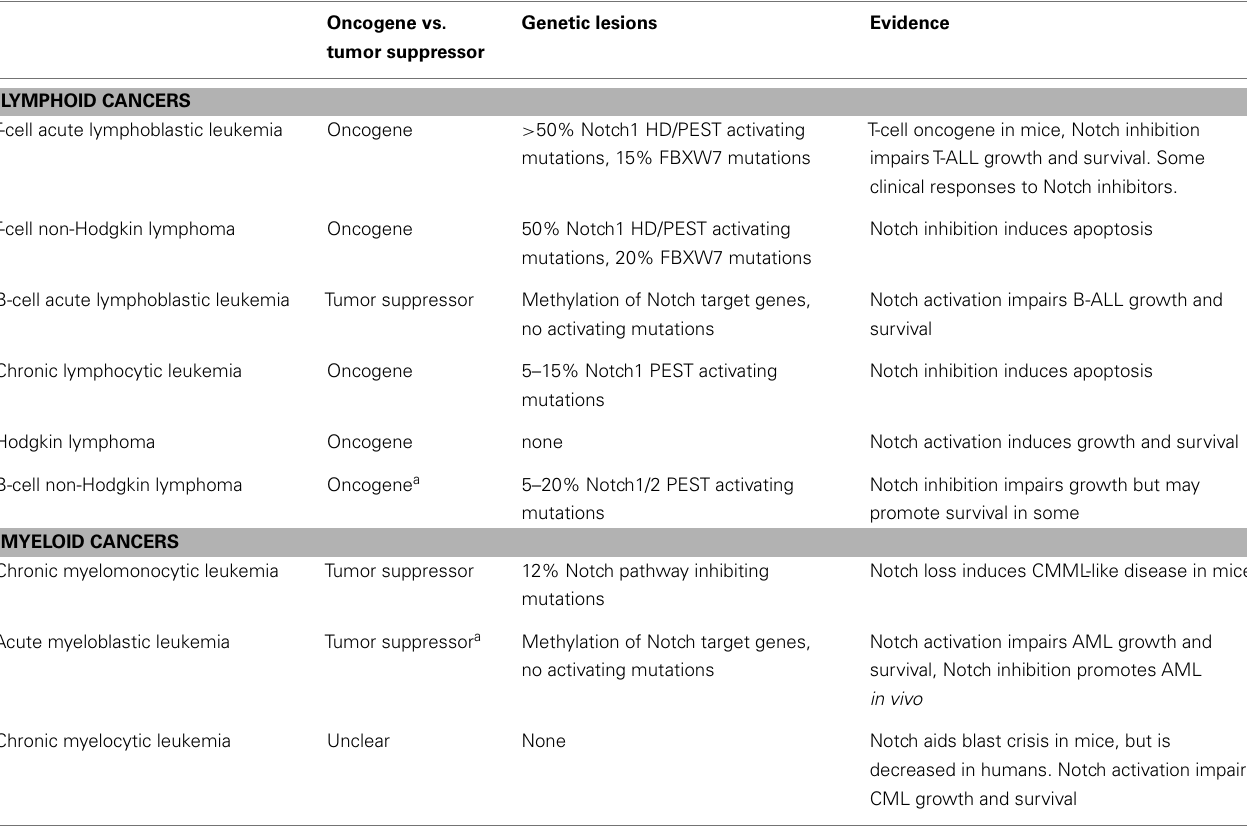
Table 1 |The Notch pathway by cancer type .